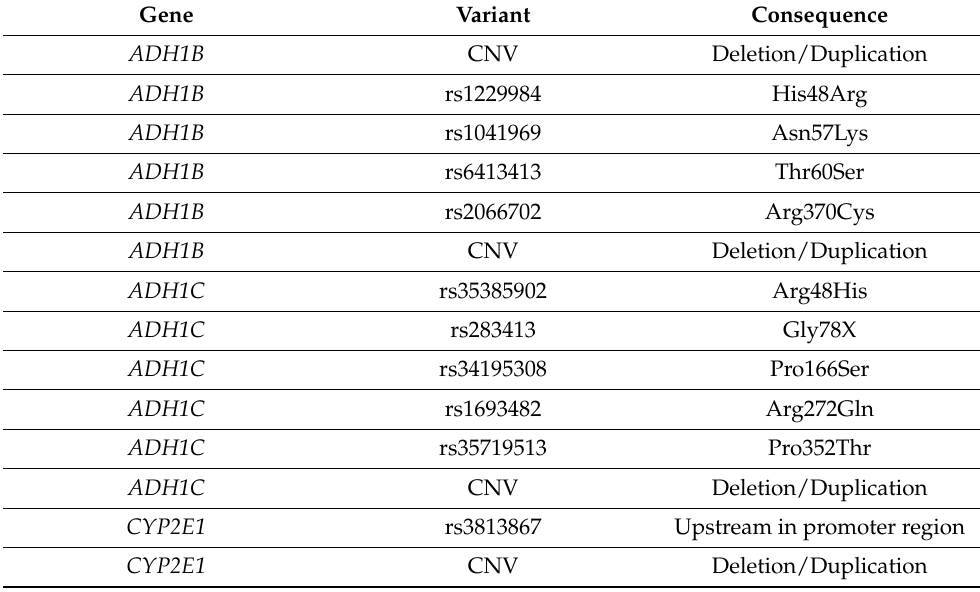
Table 2. Selection of SNVs and CNVs